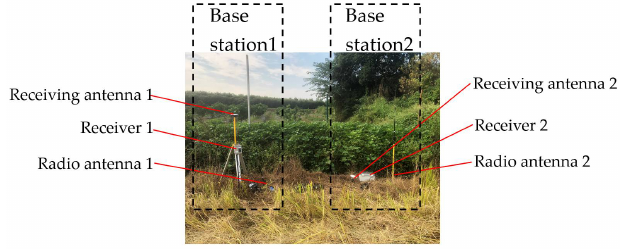
Figure 11. Setup of the RTK-GNSS base stations.